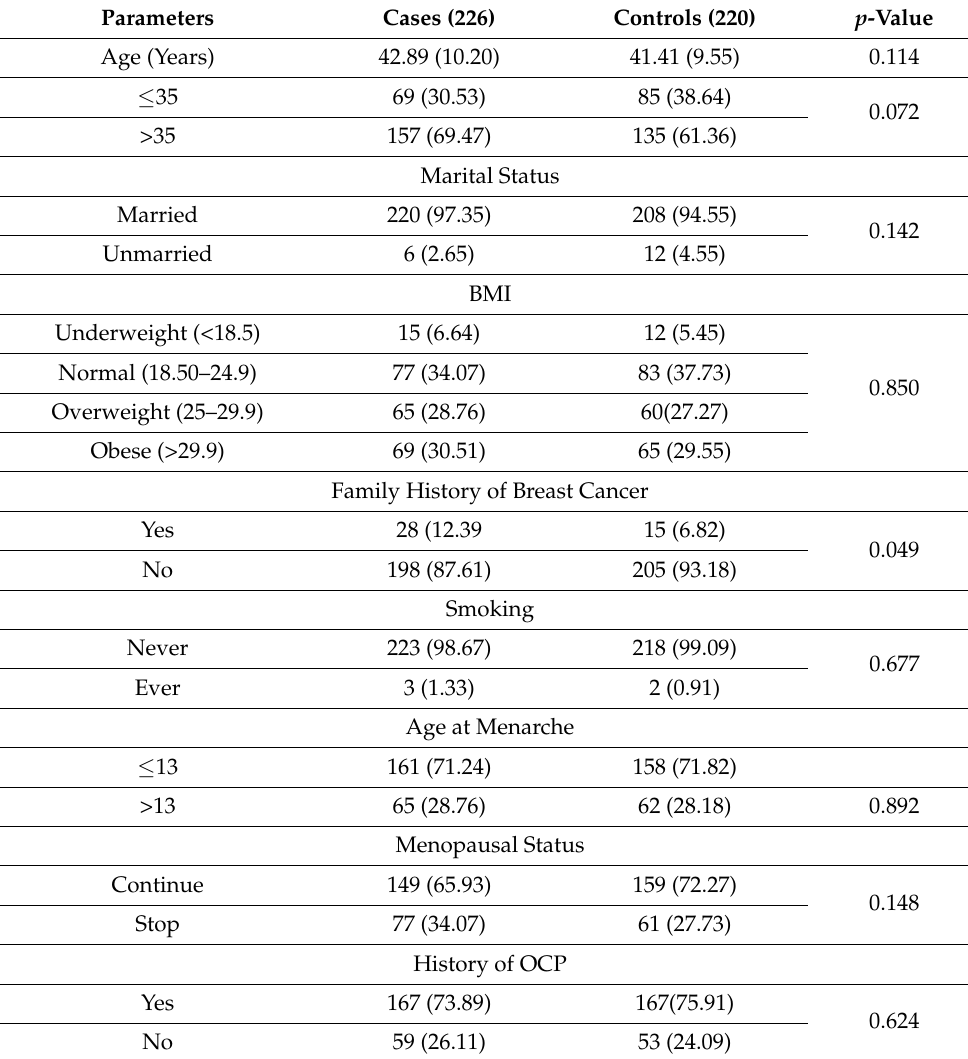
Table 2. Demographic and clinicopathological features of breast cancer patients.